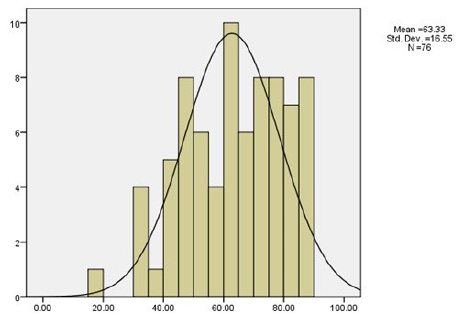
Figure 3. The diameter of the inferior vena cava before resuscitation (horizontal) by frequency